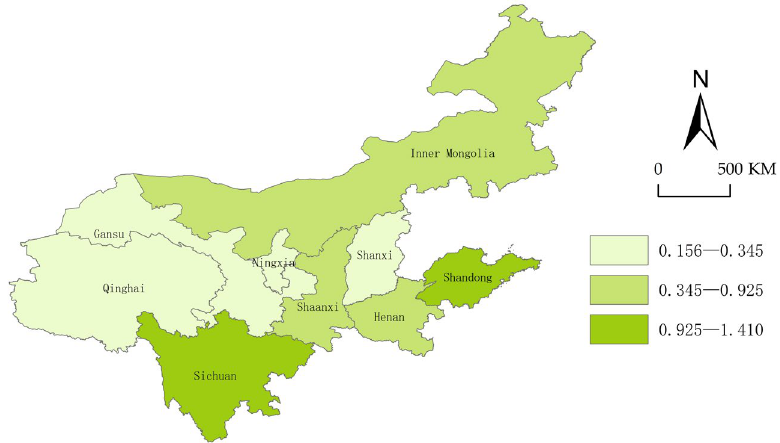
Figure 6. Security landscape of the Yellow River Basin (2017).